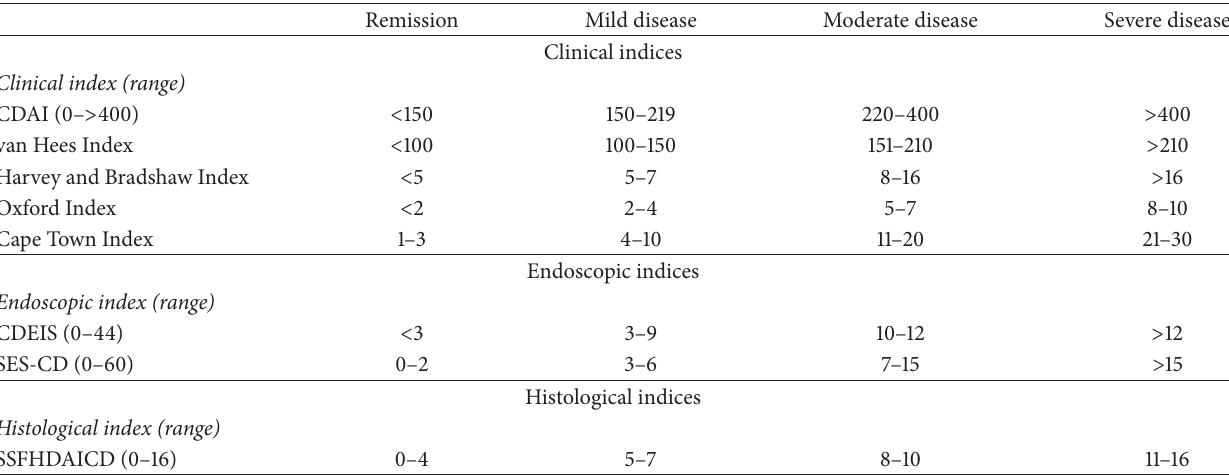
Table 2: Division of clinical, endoscopic, and histological indices into four CD disease activity categories for comparison purposes. Remission Mild